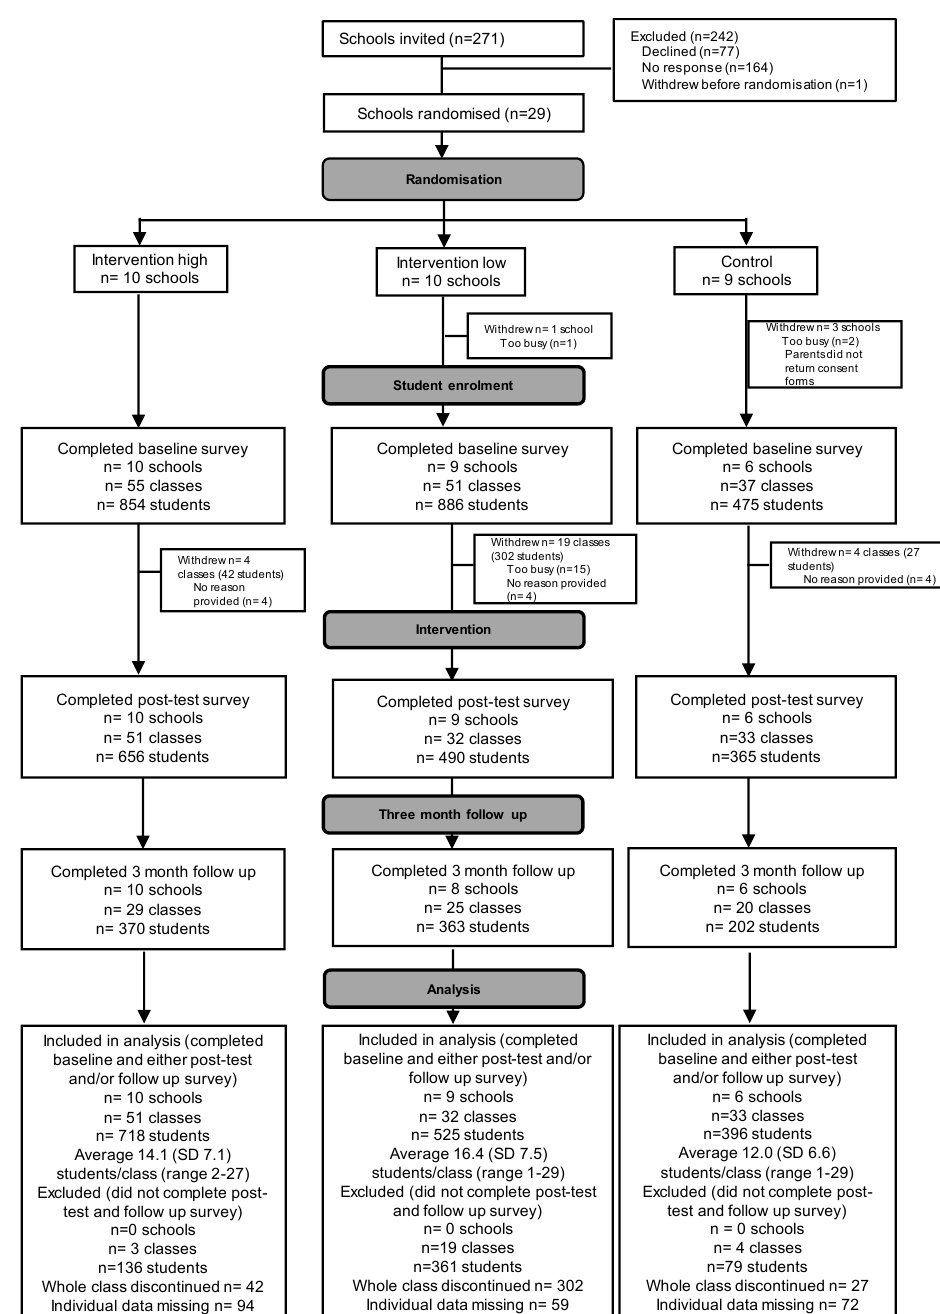
Figure 1. CONSORT participation flowchart of schools, classes and students in NSW and SA. A total of 2215 students completed the baseline test and 576 students of those (26%) did not complete further assessments. These drop-outs were largely (64% of participants) due to whole classes not continuing, particularly in one school in the low-intensity intervention arm who initially intended to take part with the whole school but decided to continue with a selected number of classes after the baseline survey due to time constraints. As a result, there was a difference in the drop-out rate by intervention arm (Supplementary Material).